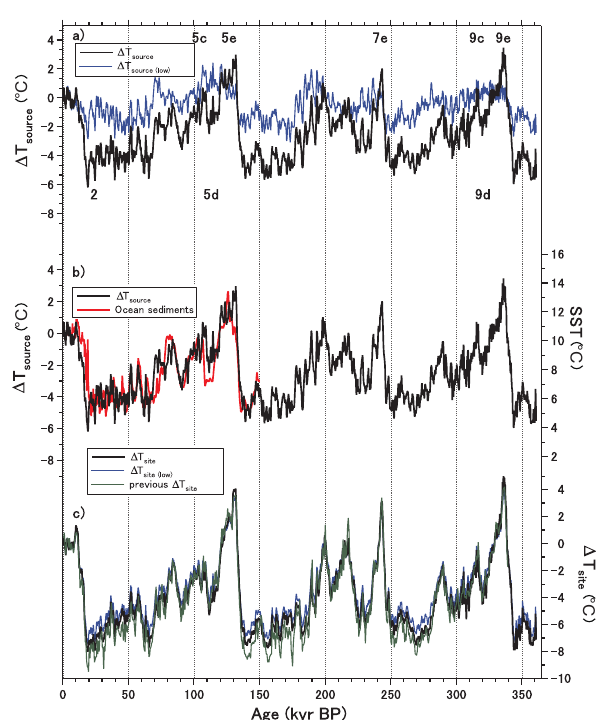
Fig. 6. Different 1T source and 1T site of DF and a stacked SST records. (a) Black line represents the 1T source record of DF core based on the coefficients ( β site = 1 . 3) obtained by isotope-fitting (this study). Blue line represents the 1T low source record of DF core based on the coefficients ( β site = 0 . 5) used for Vostok reconstruc- tion (temperature-fitting) (Cuffey and Vimeux, 2001; Vimeux et al., 2002). Numbers indicate Marine Isotope Stages. (b) Black line is the 1T source of DF core, same as (a) , but with a stacked southern SST record of ocean sediments (Barrows et al., 2007) (red line). (c) The 1T site record based on the coefficients of this study (black line), 1T low (blue line), and previous 1T site reconstruction of site